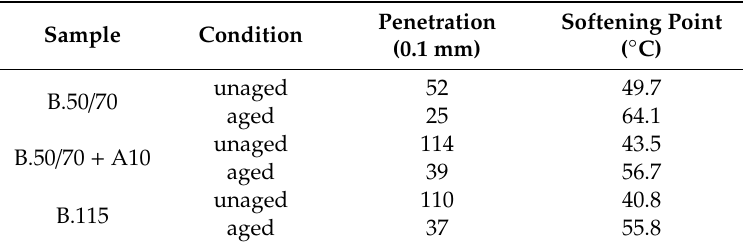
Table 1. Basic characteristics of investigated binders [19].